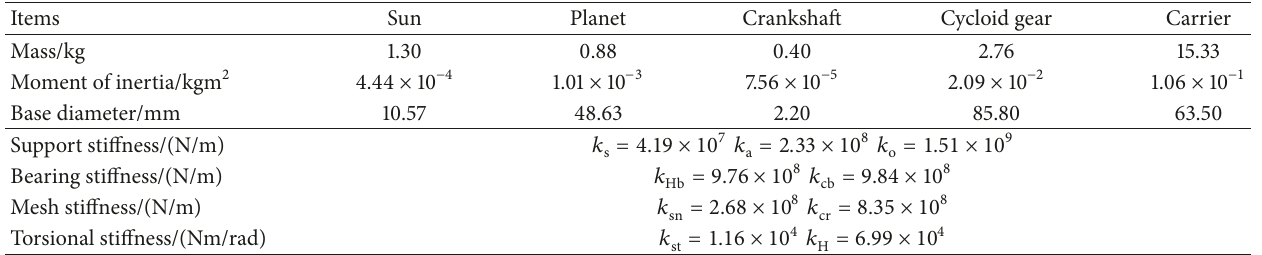
Table 1: Parameters of an example RV reducer.